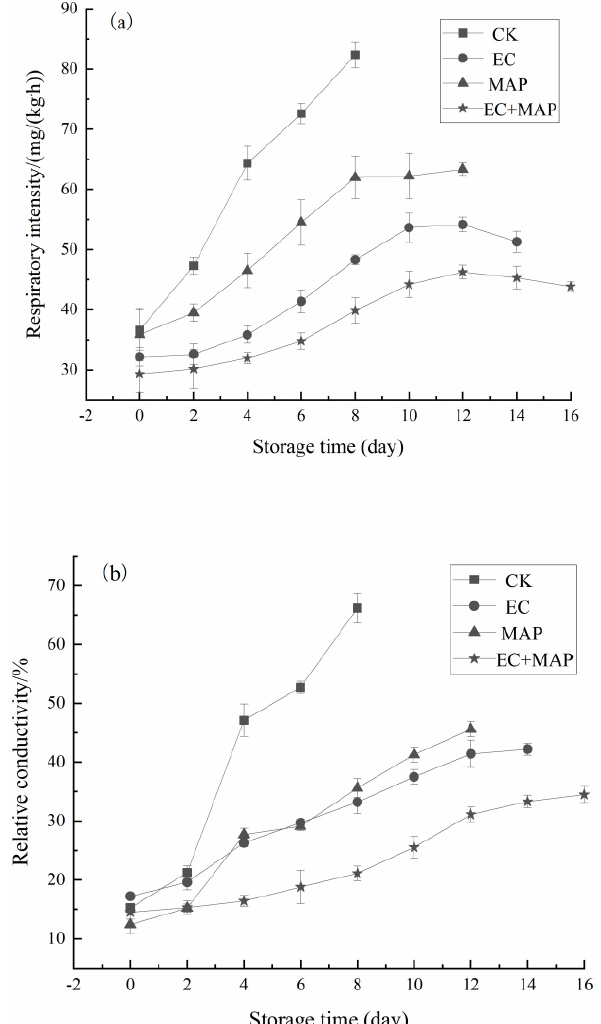
Figure 3. Effect of different treatments on respiratory intensity ( a ) and relative conductivity ( b ) of fresh-cut pineapples during storage.